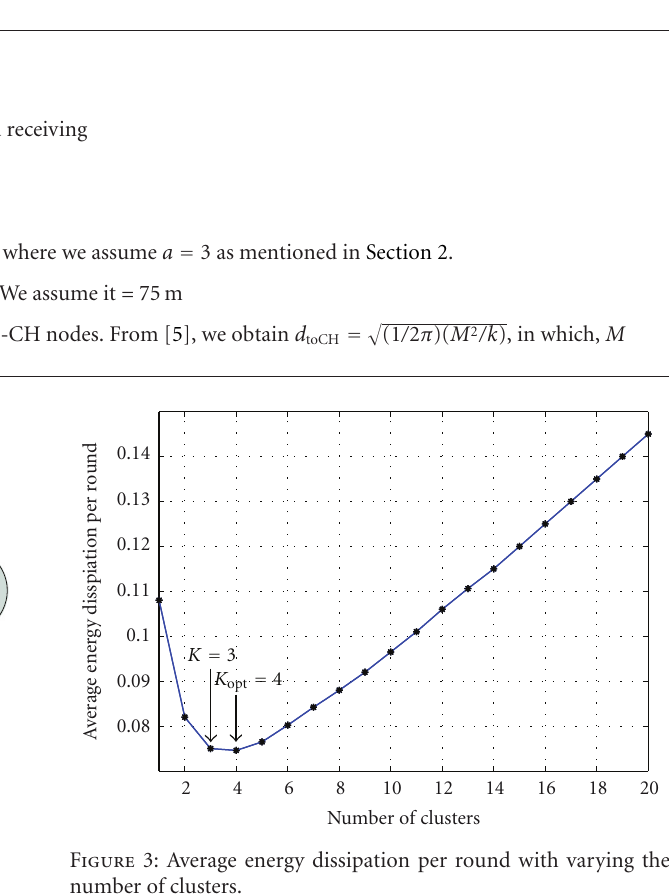
Figure 2: The clustering structure for 20 sensor nodes.